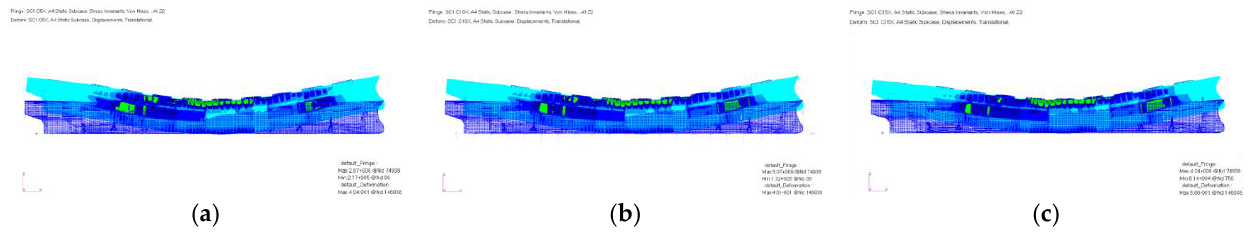
Figure 6. Ship deformation at t = 0.875 T. ( a ) 5 kn; ( b ) 10 kn; ( c ) 15 kn.